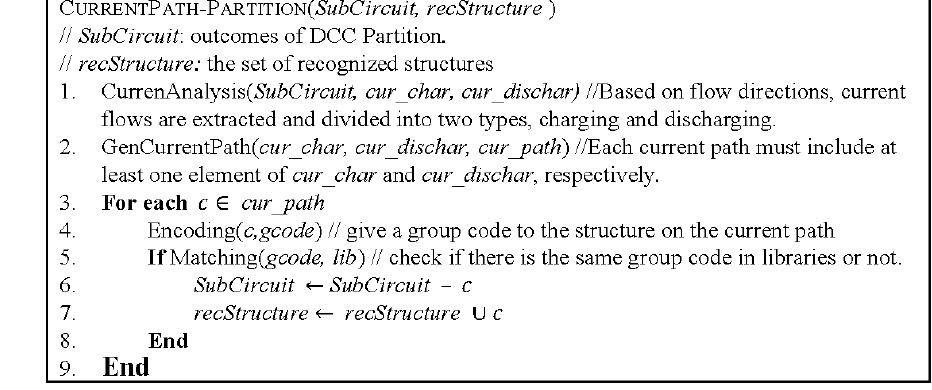
Figure 8. Pseudocode of current path-based partitioning.